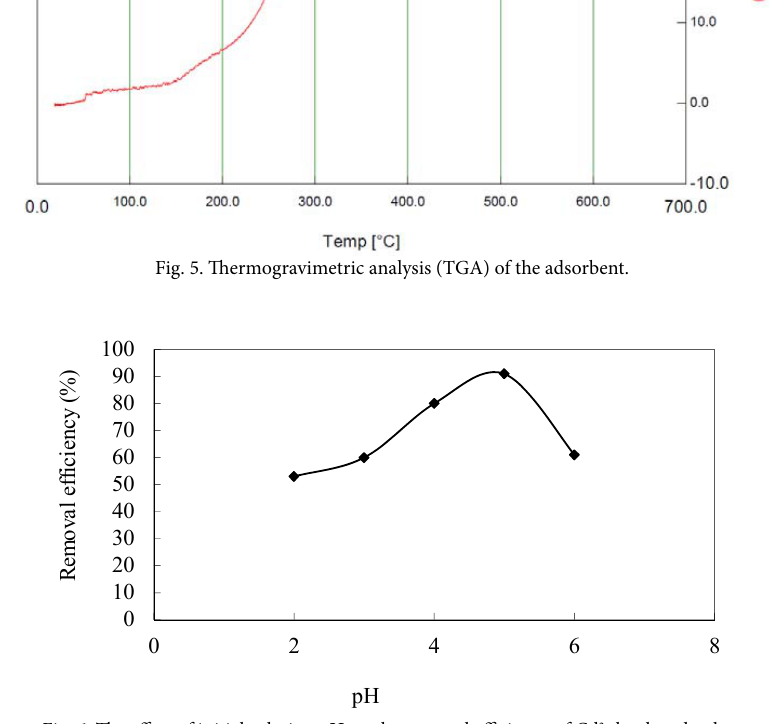
Fig. 6. The effect of initial solution pH on the removal efficiency of Cd 2+ by the